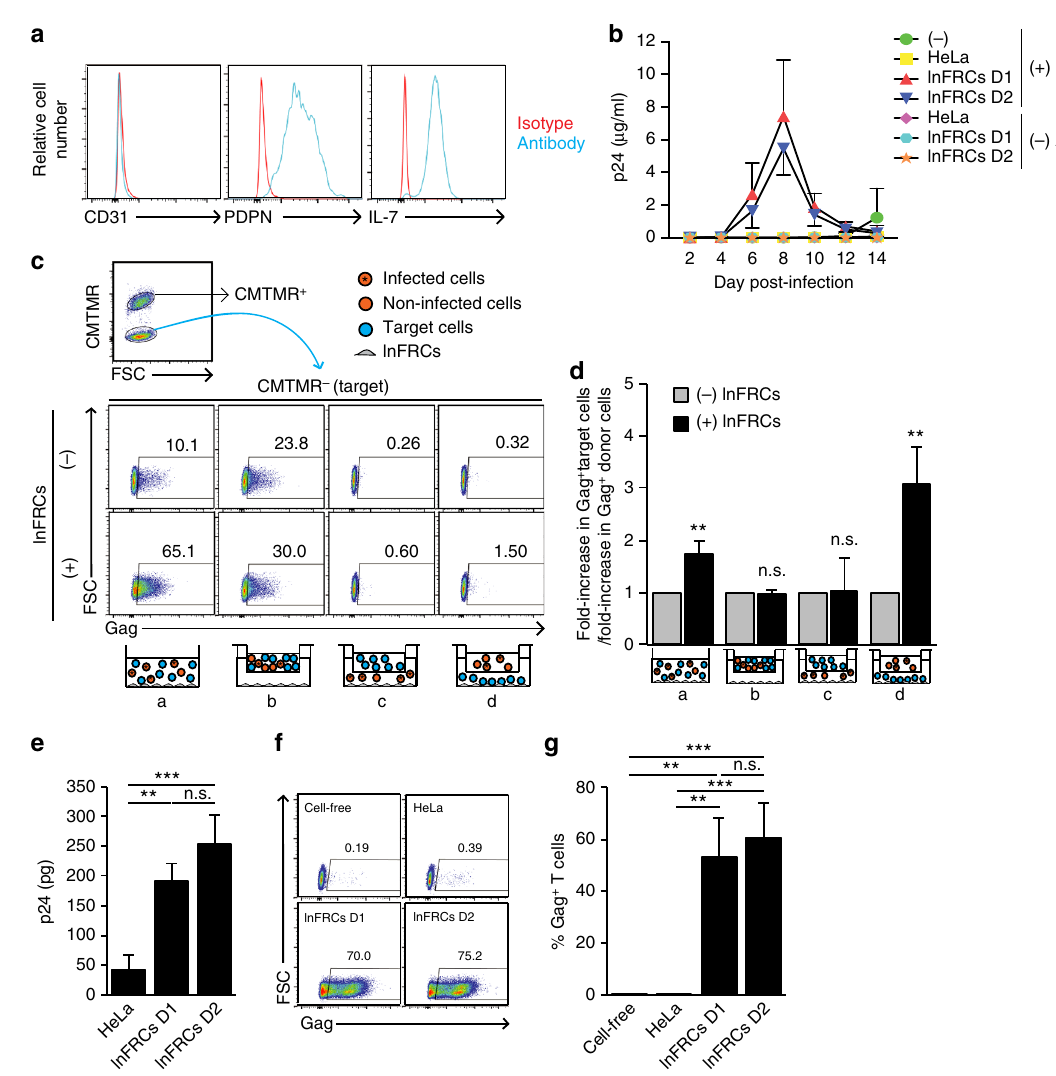
Fig. 1 Lymph node FRCs enhance HIV-1 spread via trans-infection. a Flow cytometry analysis of FRC markers on lymph node FRC (lnFRC) surface. Similar results were obtained using lnFRCs isolated from three different donors. b A3.01 T cells were inoculated with 0.254 ng p24 of HIV-1 NL4-3 in the presence or absence of HeLa cells or lnFRCs in 1 ml RPMI-10. To analyze infection of lnFRCs, lnFRCs were also inoculated with the same amount of HIV-1 NL4-3 in the absence of A3.01 T cells. To analyze HIV replication kinetics in A3.01 T cells in the presence or absence of HeLa cells or lnFRCs, the 50- µ l